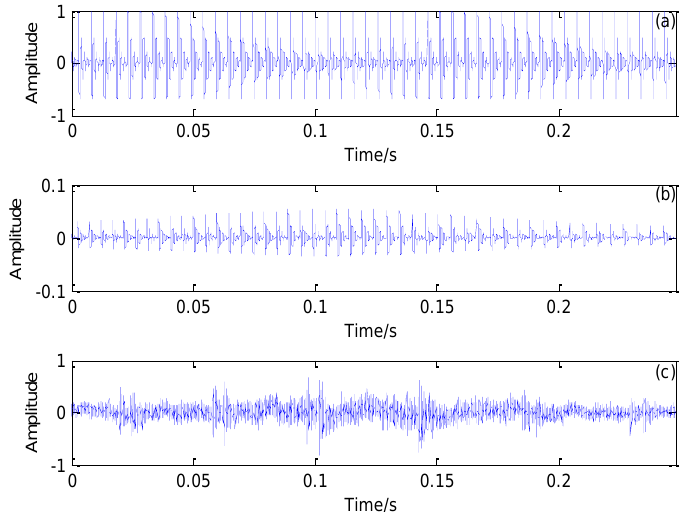
Figure 20. Results obtained by using the proposed method: ( a ) the optimal periodical transient model; ( b ) the optimal Doppler transient model and ( c ) the inner race fault